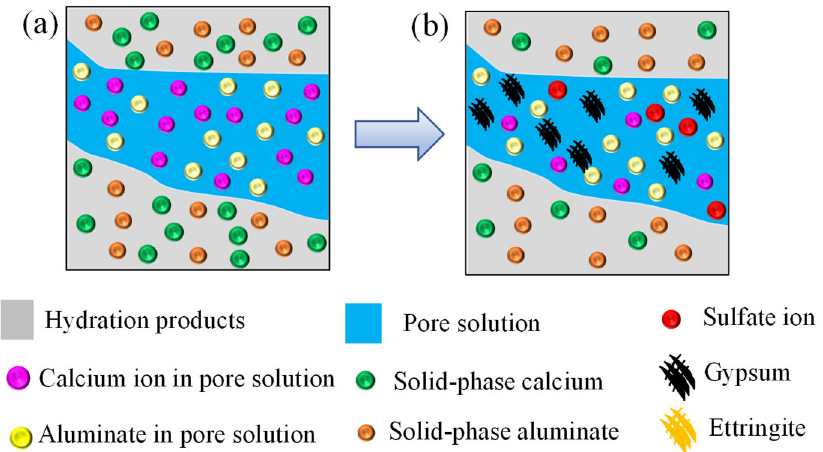
Figure 2. Schematic diagram of calcium reaction-leaching-diffusion process. ( a ) Before sulfate attack, ( b ) after sulfate attack.